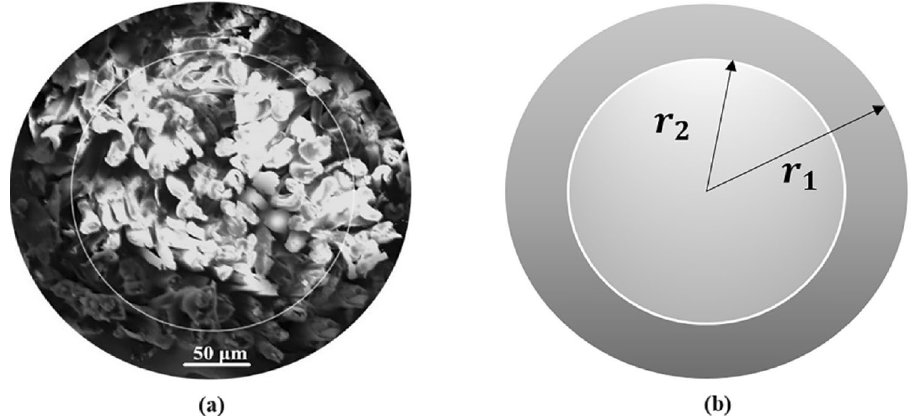
Fig. 5 Radial gradient distribu- tion the conductivity of cotton yarn. a Cross-section SEM image. b Schematic diagram of radial distribution of conduc- tive